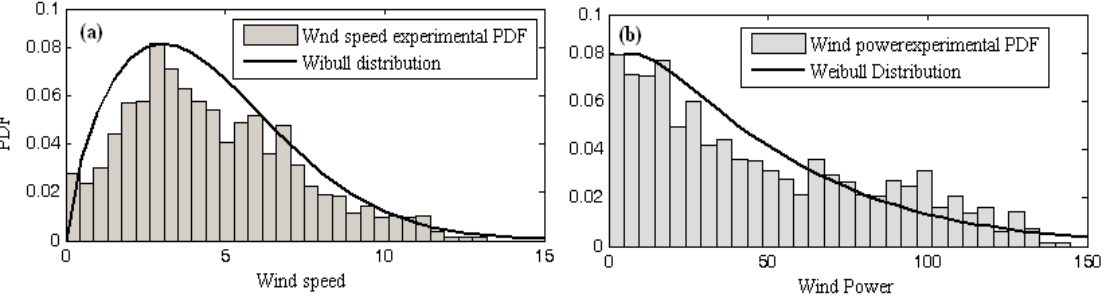
Figure 4. Experimental PDF graphs of (a) wind speed, (b) wind power in comparison with the fitted Weibull